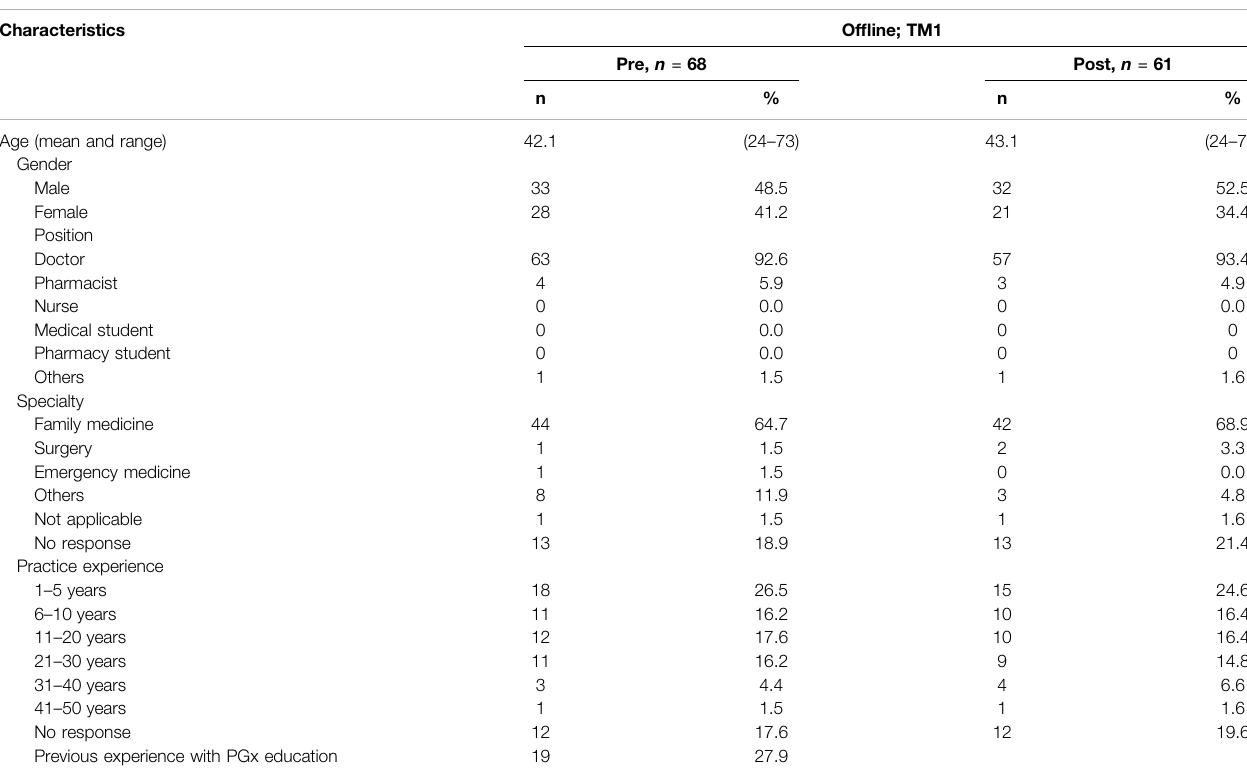
TABLE 1 | Participant characteristics in of fl ine TM1 training.